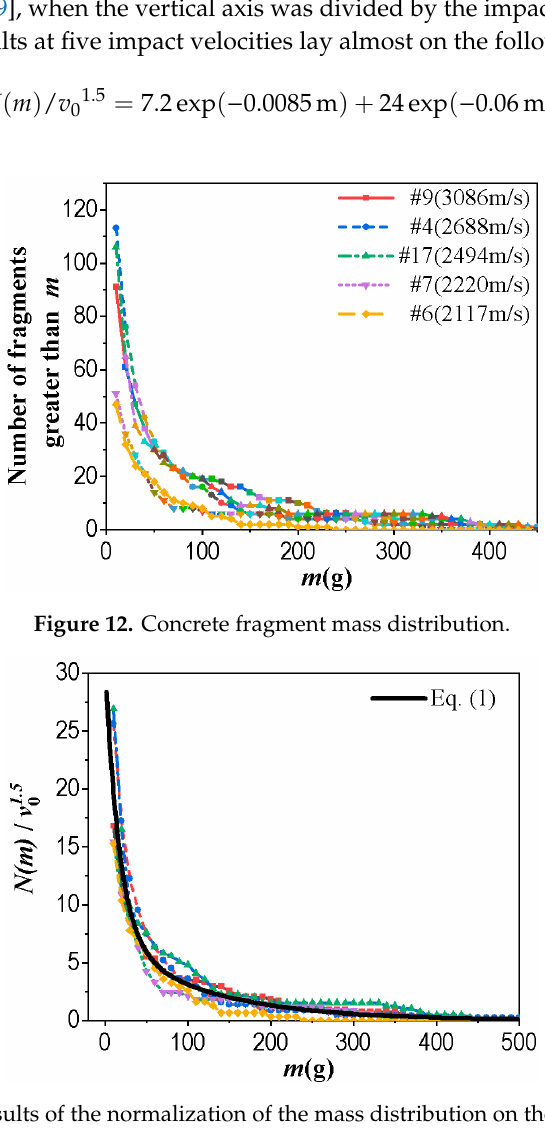
Figure 11. The proportion of fragment mass of each interval.